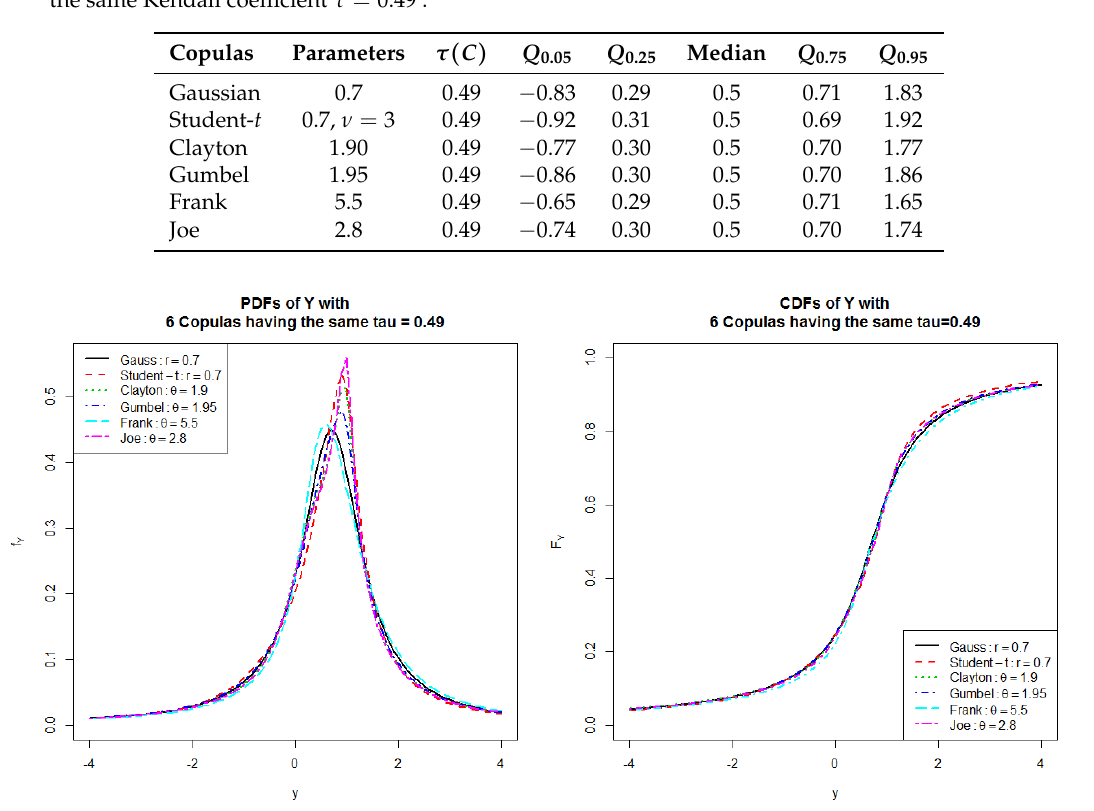
Figure 13. PDFs and CDFs of the ratio Y = X 1 same τ =